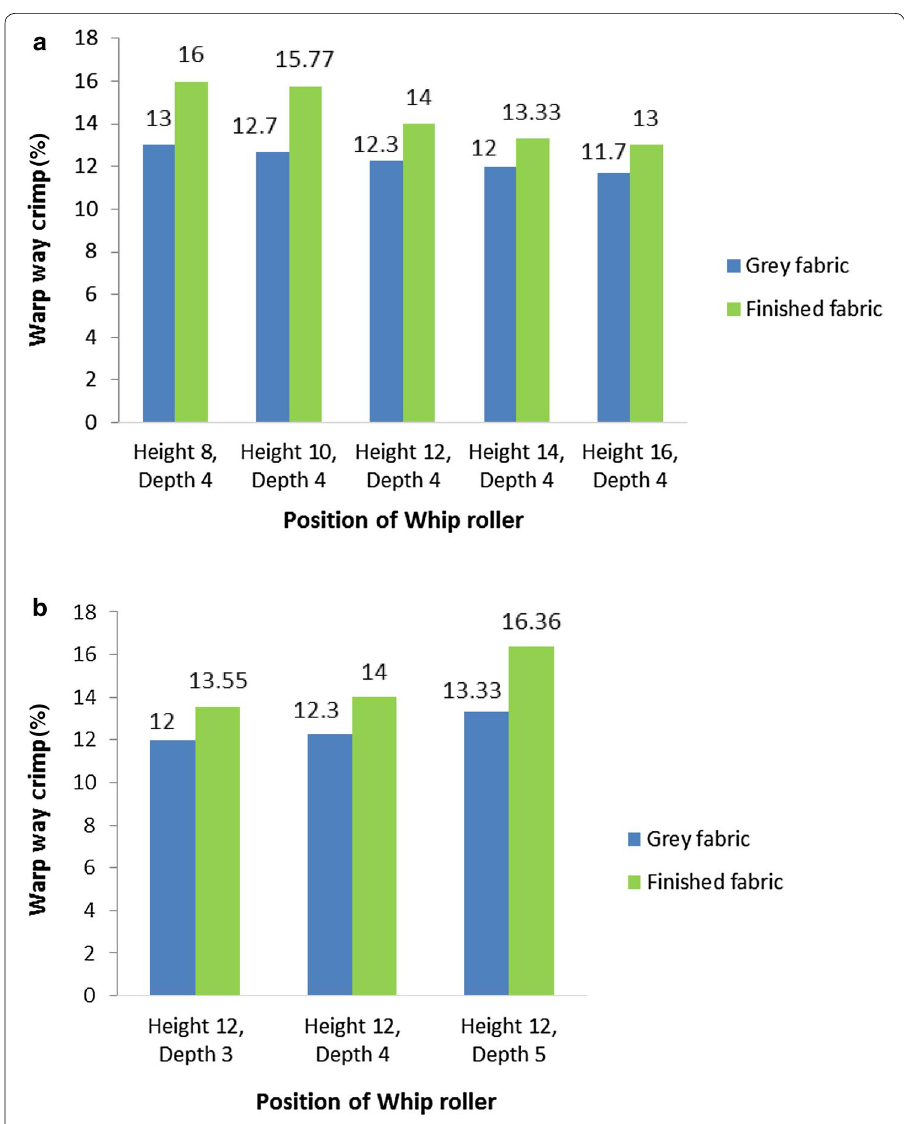
Fig. 4 a Warp way crimp (%) at variable height and constant depth of whip roller. b Warp way crimp (%) at constant height and variable depth of whip